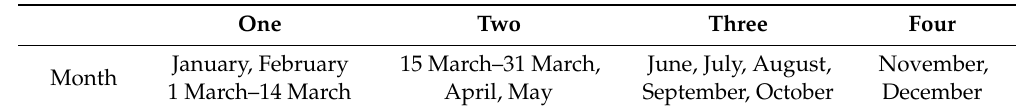
Table 6. Clustering results for four classes.